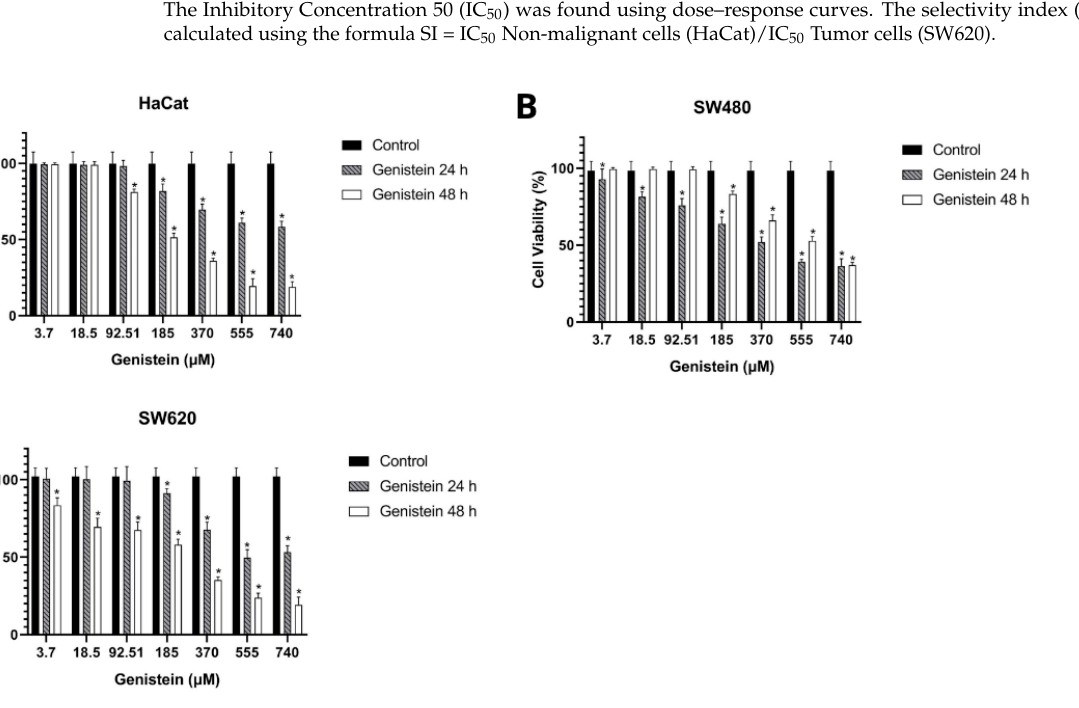
Figure 3. Effect of genistein on cell viability after 24 h and 48 h of treatment compared to the control ( A ) non-malignant HaCaT cell line, ( B ) SW480 colorectal adenocarcinoma cell line, and ( C ) SW620 colorectal adenocarcinoma cell line. All tests were performed in quintuplicate. p -value < 0.05 *. Based on the IC50 value of free genistein, cytotoxicity assays of empty BNC capsules and BNC/GEN were performed. Figure 4 shows that the empty NCB capsules do not have a cytotoxic effect on any of the cell lines evaluated, since they showed a percentage of cell viability greater than 96% both at 24 and 48 h of incubation. Comparing the eval- uated concentration of the IC50 of free and encapsulated genistein, it can be seen that there is a greater effect on the decrease in cell viability of BNC/GEN both at 24 and 48 h. This is associated with the protection offered by the BNC to the compound from the pH of the medium, which allows a controlled and prolonged release of it over time.